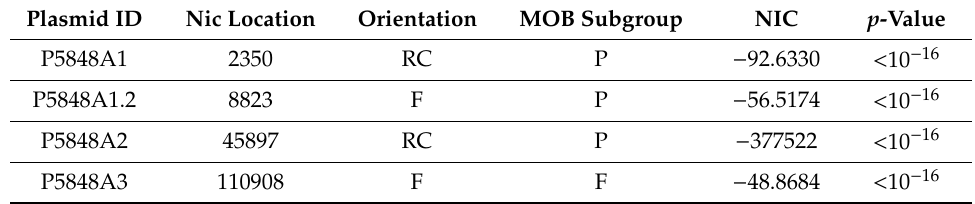
Figure 4. Growth rate of isolates with or without bacteriocin and resistance genes containing plasmids in the presence or absence of cefotaxime. Results showing the growth rate (UFC / mL) of each competitor. Squares, triangles and circles indicate replicates. No statistically significant di ff erence was found when comparing growth rates of DH5 α (wild type) and DH5 α + (transformant strain). Table 3. Results of the prediction of transfer range using